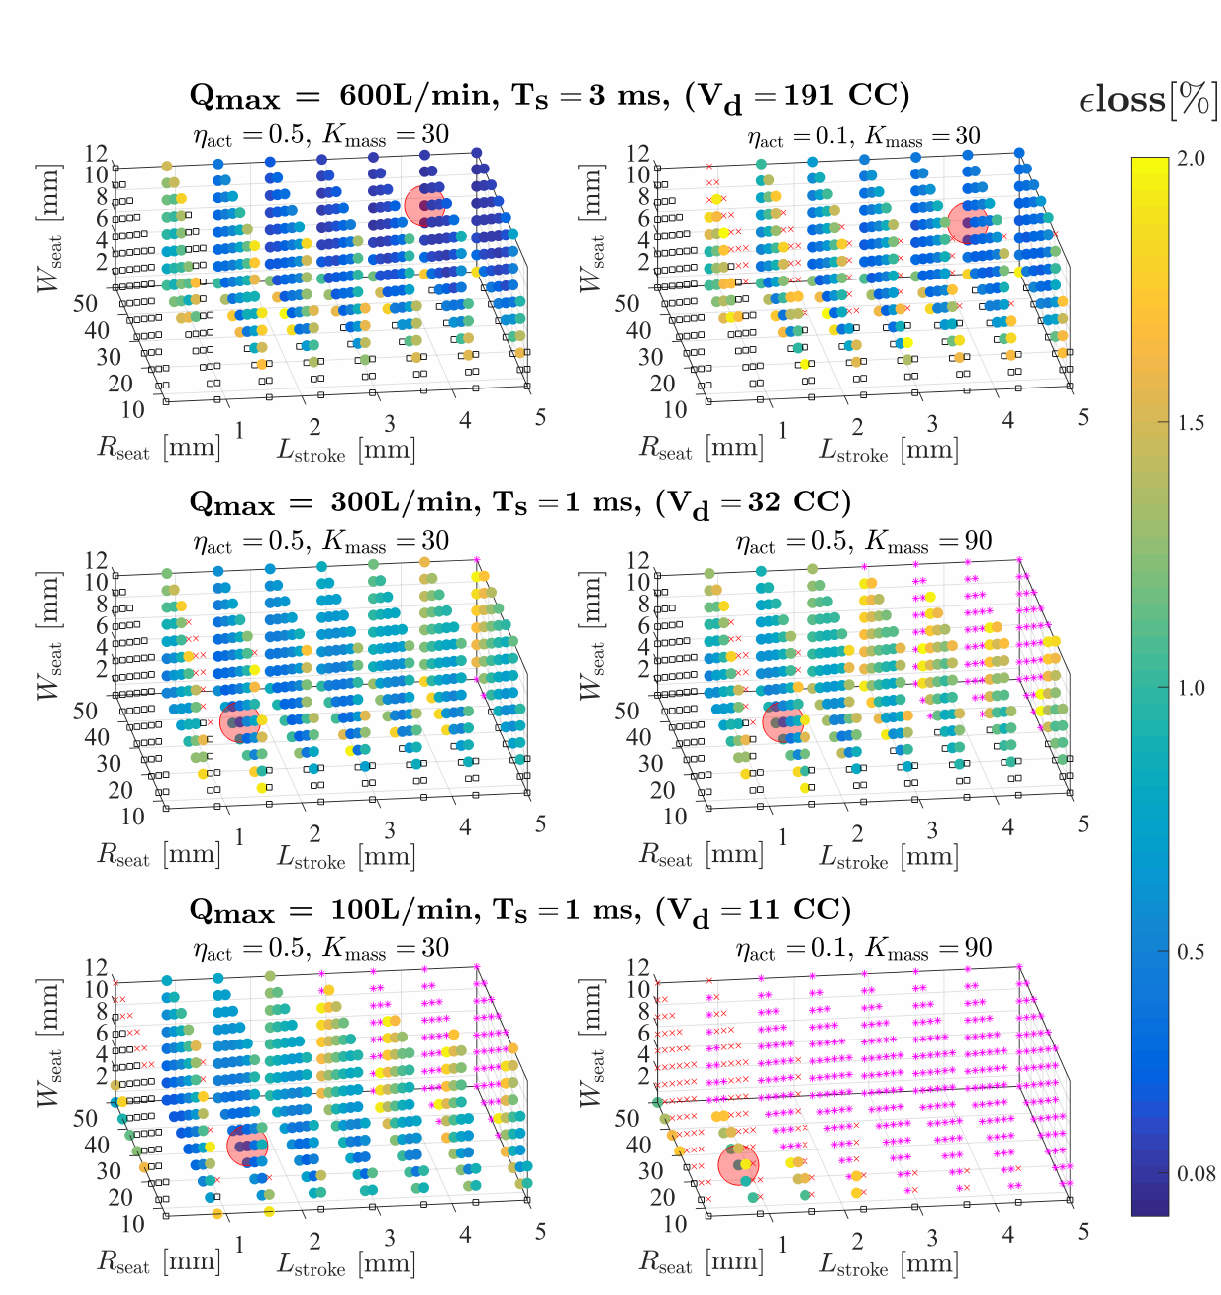
Figure 16: Relative valve losses throughout the design space, for different flow rates and valve switching times and model coefficients. The black, red and magenta points represent designs where (cid:15) loss > 2% and the colors indicate which loss is dominant: black square is flow loss, red cross is the passive loss, and magenta star is the acceleration loss. The larger opaque red circles indicate the optimum valve sizing for the respective operating